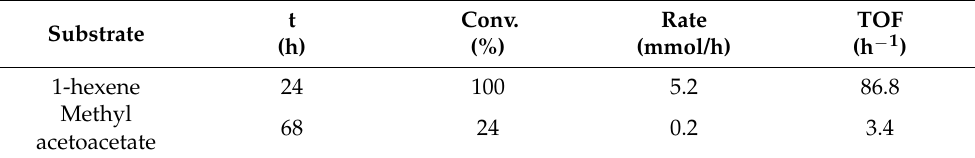
Table 3. Reaction rate obtained with 0.0510 g of 2 , in the hydrogenation of 8.37 mmoles of methyl acetoacetate in 20 mL of methanol as solvent, at 50 ◦ C of temperature and 7 atm. of initial hydrogen